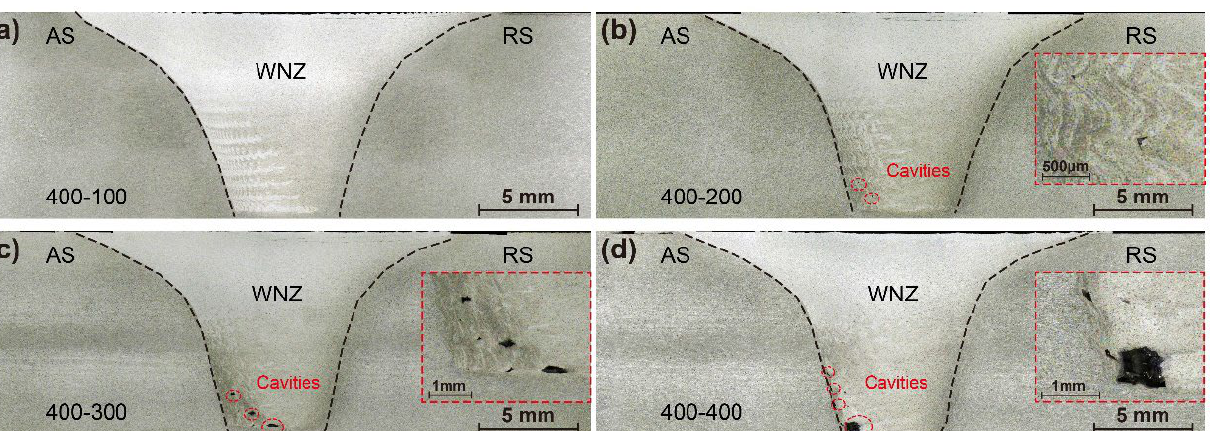
Figure 6. Temperature curves at different positions of ( a ) Pin-1-400-200 and ( b ) Pin-2-400-200.